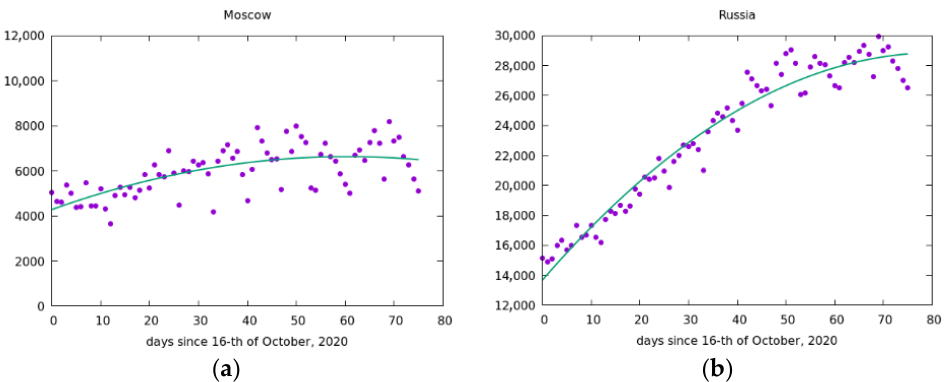
Figure 12. Infections per day during second wave in ( a ) Moscow (maximum of parabola points to 10th of December) and ( b ) Russia, for which the maximum has not been reached yet and is expected to be reached sometime around 31st of December.